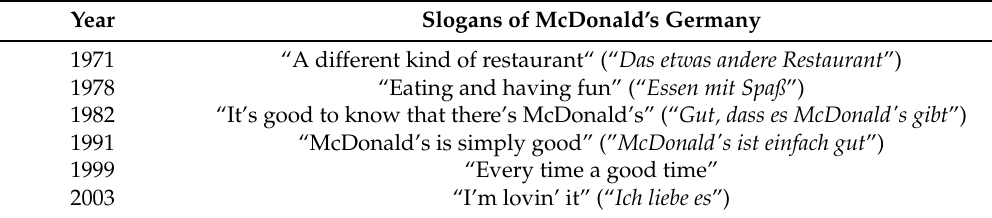
Table 1. Slogans of McDonald’s Germany, based on [96] (p.